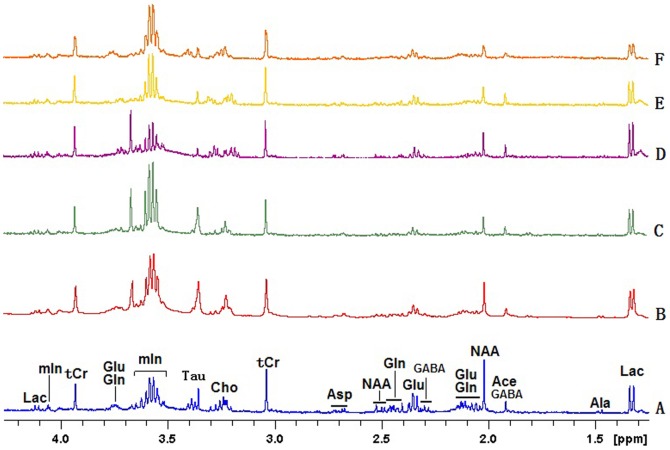
Representative in vitro
1H NMR spectra at 9.4T from control (A) and senescent mice induced with D-galactose and NaNO2 on day 30 (B), day 40 (C), day 50 (D), day 60 (E), and day 70 (E), respectively.Lac: lactate; Ala: alanine; Ace: acetate; GABA: g-aminobutyric acid; NAA: N-acetylaspartate; Glu: glutamate; Glu: glutamine; Asp: aspatate; tCr: total creatine (creatine and phosphocreatine); Cho:choline; mIn: myo-inositol.